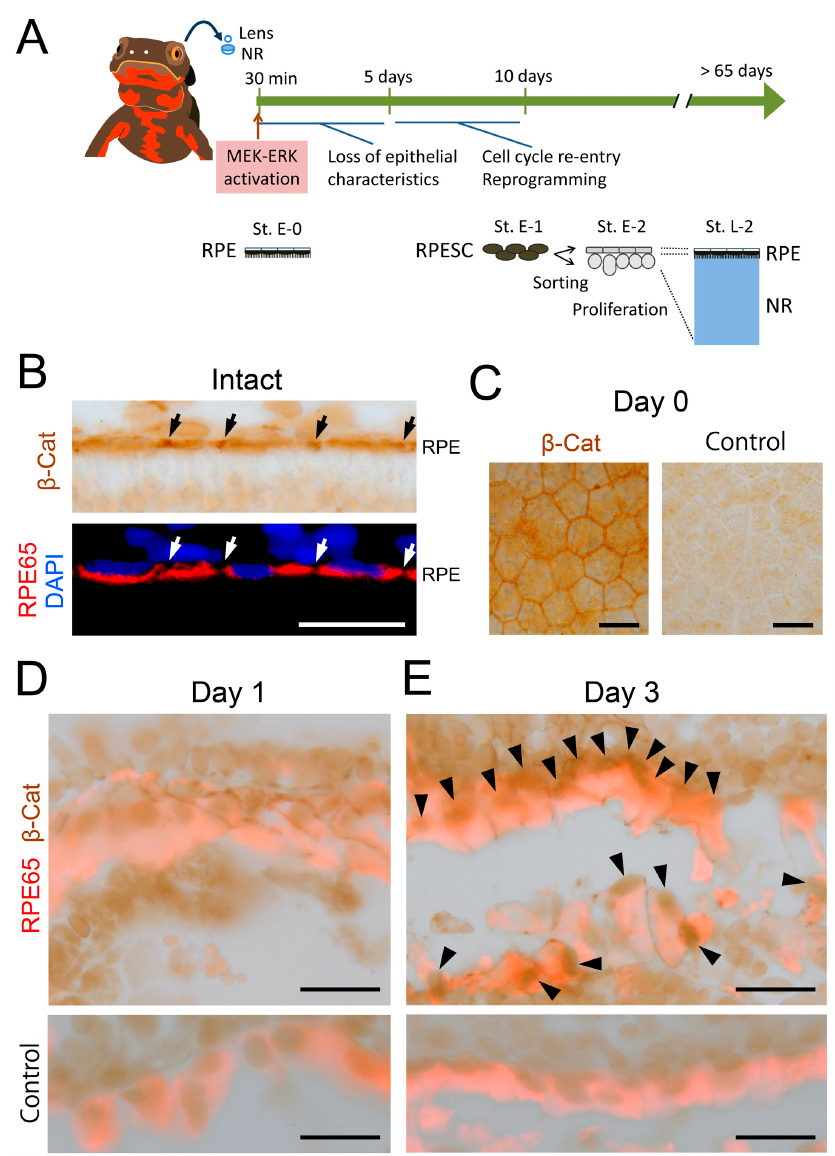
Figure 5. β -Catenin signaling is activated in 3 days after retinectomy in vivo. ( A ) Schematic showing events that take place during retinal regeneration; ( B ) Representative β -catenin immunoreactivity along the RPE layer in the intact eye ( n = 3). The tissue was bleached. Intense immunoreactivity was observed in the region of cell–cell contact in the RPE (black and white arrows). Lower panel: RPE65 immunoreactivity merged with DAPI nuclear stain in the same region; ( C ) Representative β -catenin immunoreactivity in the RPE sheet of the eye immediately after retinectomy (day 0) ( n = 3). Intense immunoreactivity was observed along the cell membrane which was in contact with neighboring cells. Right hand panel: representative staining with control IgG as the primary antibody ( n = 3); ( D ) Representative β -catenin immunoreactivity in RPE cells at 1 day after retinectomy ( n = 3). The tissue was double stained with RPE65 antibody and bleached. At this stage, immunoreactivity was not detected in the nuclei of RPE cells; ( E ) Representative β -catenin immunoreactivity in RPE cells/RPE-derived mesenchymal-like cells at 3 days after retinectomy ( n = 3). Intense immunoreactivity was observed in the nuclei of RPE cells/RPE-derived mesenchymal-like cells (arrowheads), suggesting the activation of β -catenin signaling in this stage. Lower panels in ( D ) and ( E ): representative staining of the same stage of tissue using control IgG instead of β -catenin antibody ( n = 3 each). Scale = 50 μ m.